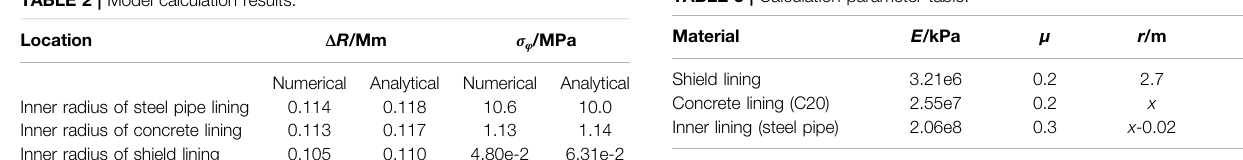
TABLE 2 | Model calculation results. TABLE 3 | Calculation parameter